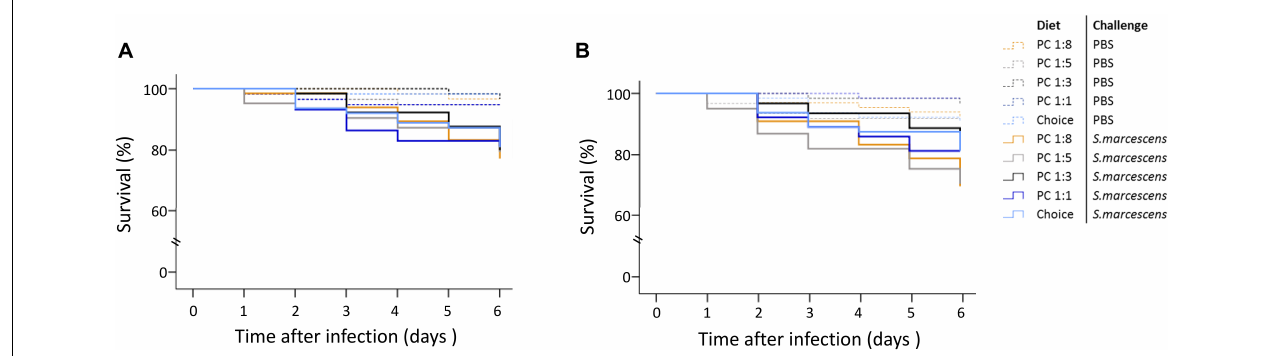
FIGURE 4 | Effect of paternal diet on offspring survival during the first 6 days post septic infection. Fathers were fed one of five diets varying in the protein-to-carbohydrate ratio (PC ratio) whereas mothers were fed a choice diet. Their sons (A) and daughters (B) were injected with either PBS or Serratia marcescens at adult stage. Lines indicates Kaplan–Meier survival curves [dash lines (non-infected flies), continuous lines (infected flies). Colours indicate paternal diet treatments [orange (PC 1:1), light grey (choice diet), dark grey (PC 1:3), dark blue (PC 1:5) and light blue (PC 1:8)]. Significant differences between survival curves were determined by Cox regression analysis at P < 0.05.